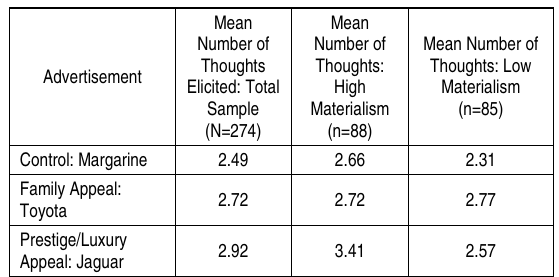
Table 3. Average number of thoughts